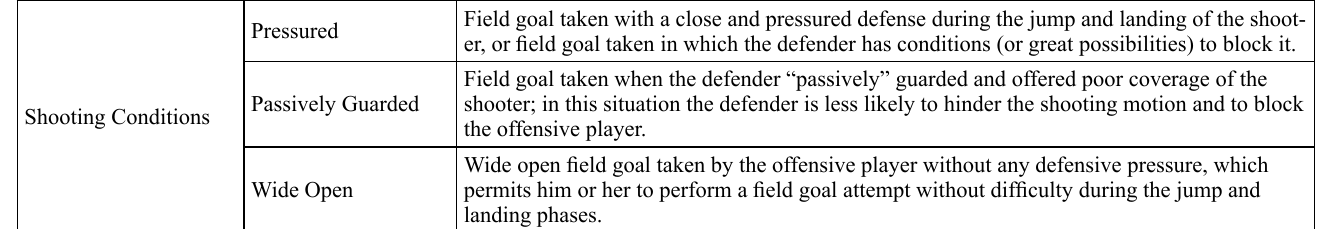
Table 1. Relationship between number of passes and shooting efficacy.